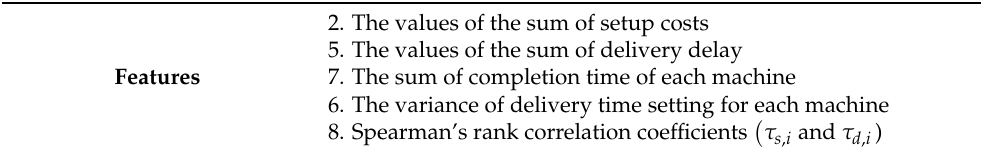
Table 5. List of features selected by SFS for large-scale problems for 2 objectives.